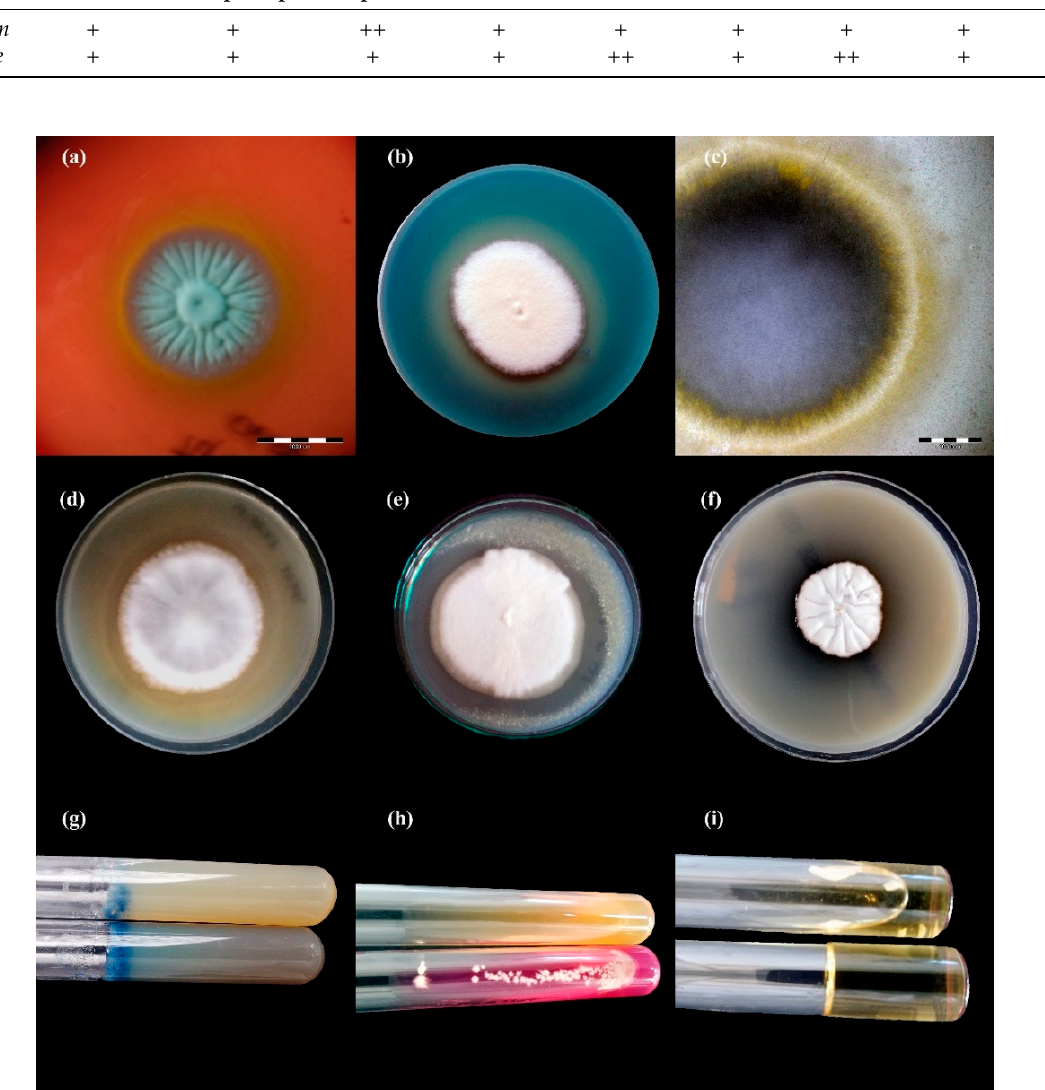
Figure 3. Enzymatic activity of Trichophyton benhamiae isolates after 21 days of incubation (picture ( b , d – i ): Nikon D3300, lens Nikon 18–105 mm VR; picture ( a , c ): Olympus SZ61, Tokio, Japan). Legend: ( a ), haemolysis; ( b ), protease; ( c ), lipase; ( d ), phospholipase; ( e ), elastase; ( f ), DNase; ( g ), keratinase; ( h ), urease; ( i ), gelatinase.